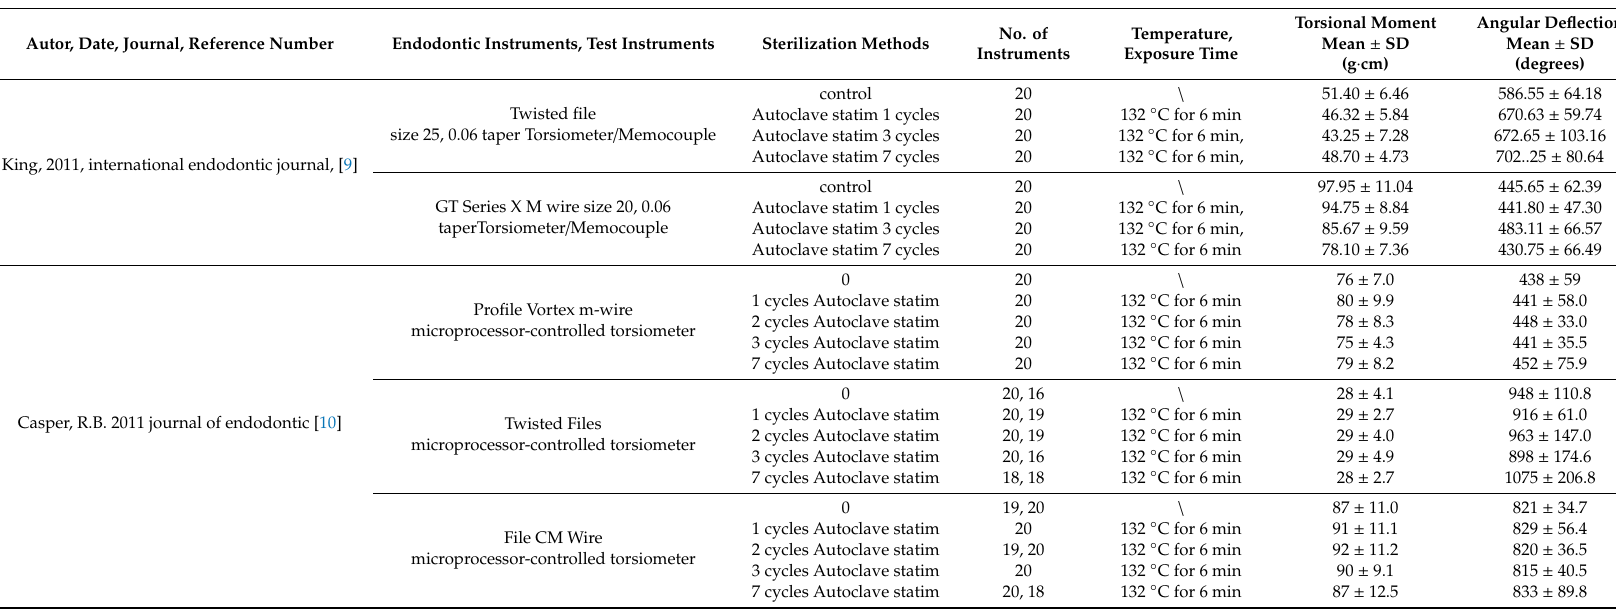
Table 5. Data extracted from studies concerning the torsional moments and the deflection angles of the instruments manufactured with the new alloys (M wire and controlled memory (CM) wire) at 0, 1, 2, 3, and 7 autoclave cycles.